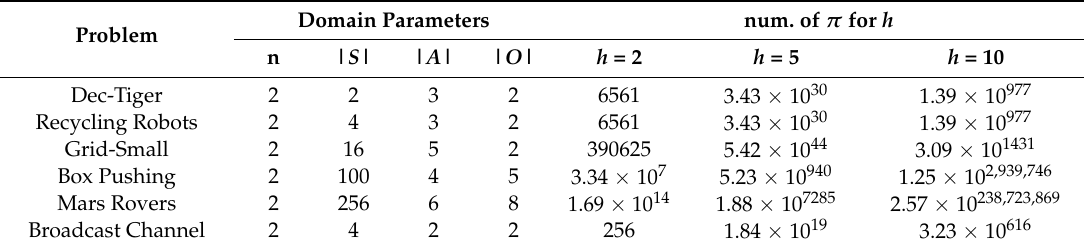
Table A1. Domain parameters and number of π for different h